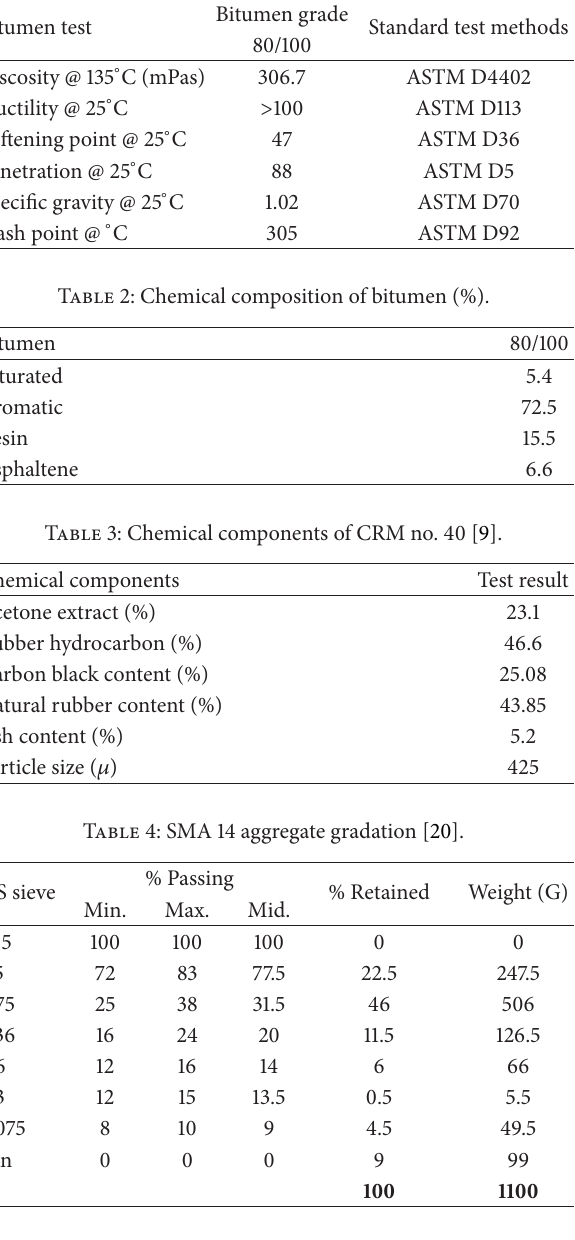
Table 1: Physical properties of bitumen.